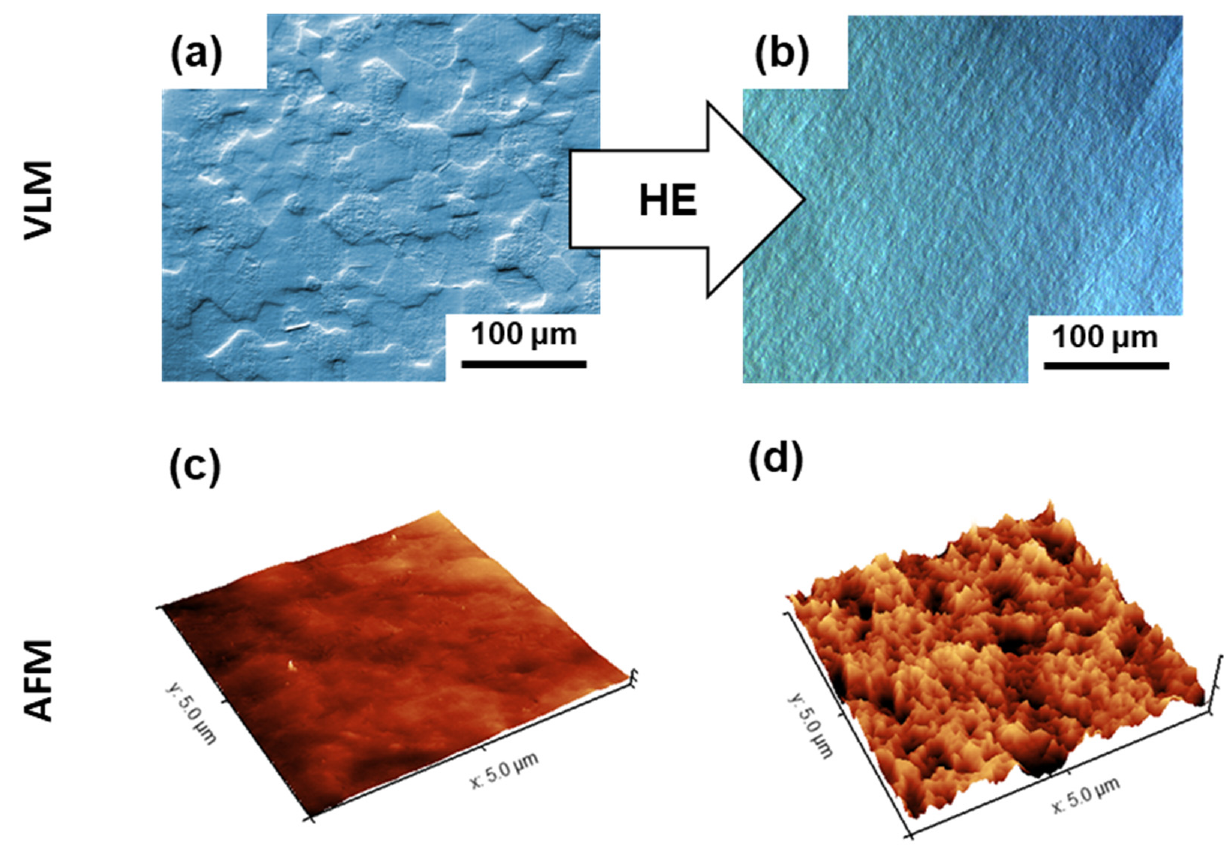
Figure 2. Microstructure of the ( a ) microcrystalline Ti and ( b ) nanostructured Ti (VLM micrographs with DIC contrast), ( c ) microcrystalline Ti, and ( d ) nanostructured Ti (AFM images).